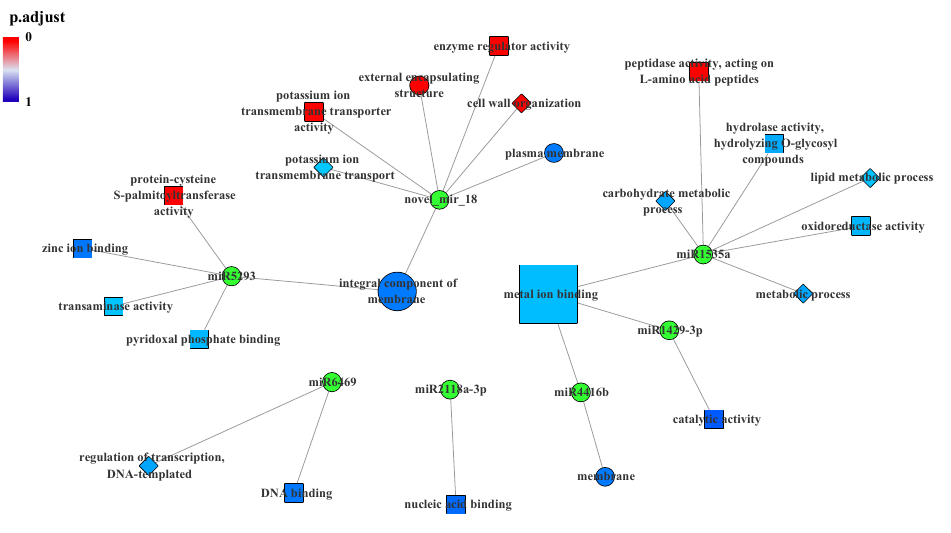
Figure 6. GO terms of target genes of miRNAs co-regulated by LT and NO. The circle represents the biological process term, the square represents the cellular components term and the diamond represents the molecular function term. The filling color of the GO term from blue to red represents the enrichment degree (p.adjust) of the GO term.